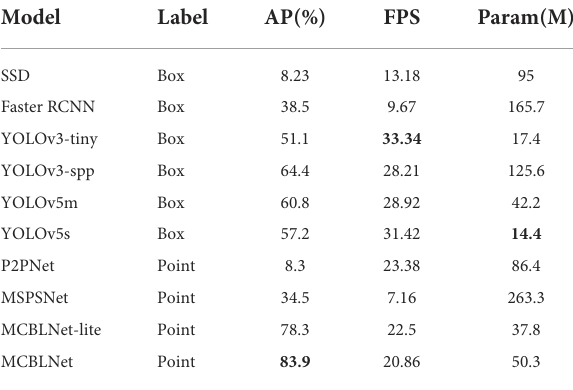
TABLE 1 Table of experimental results for each method on the CBL dataset.